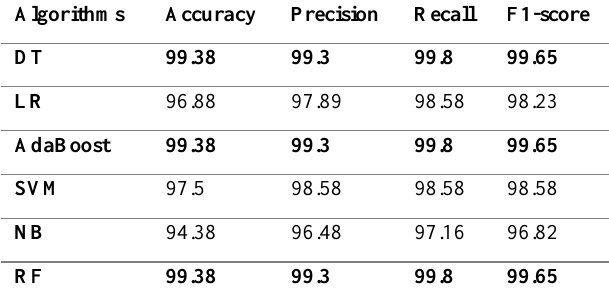
Table 6 . Evaluation results of each model for safe or unsafe